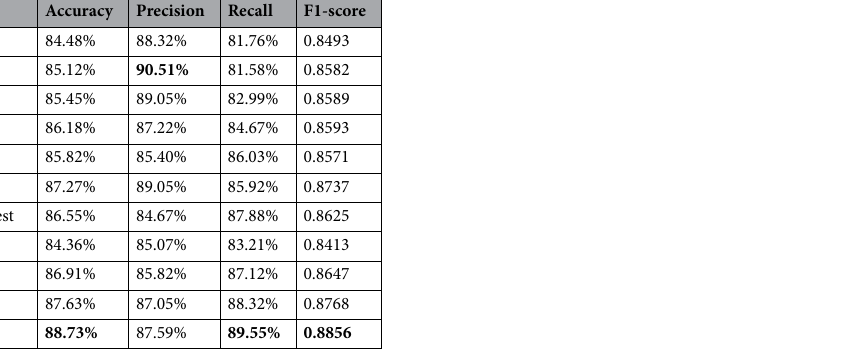
Table 3. Comparison of classification performance of various methods. Significant values are in